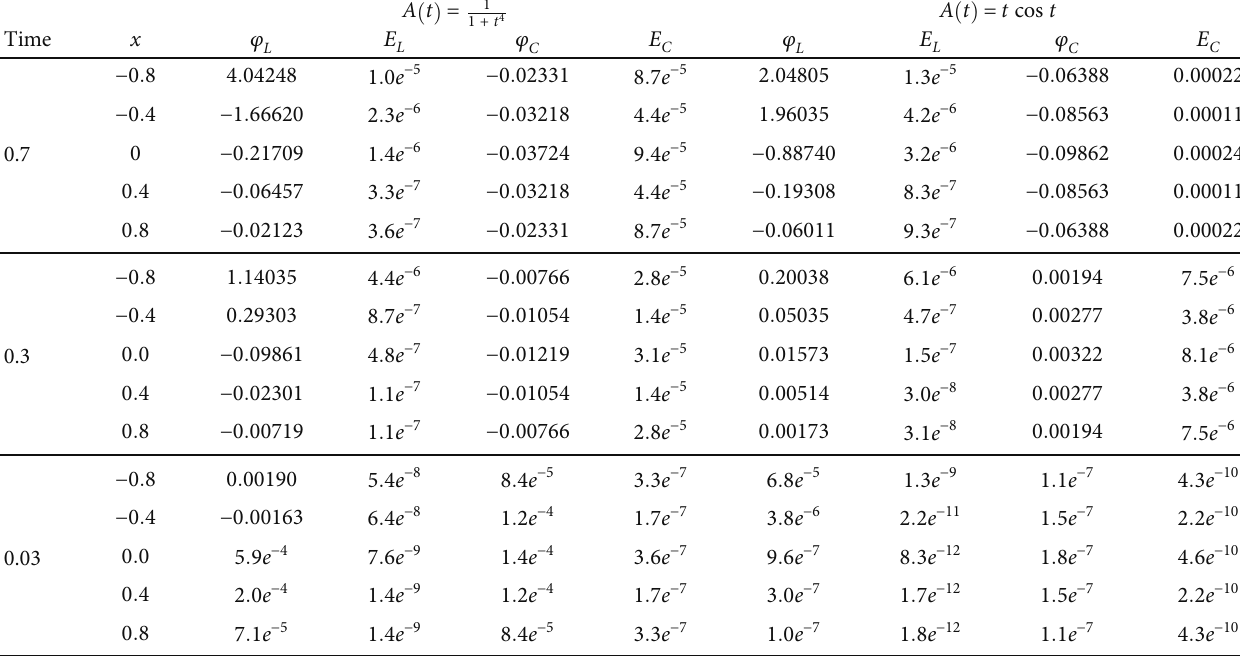
Table 2: N = 17, L ð x Þ = ð 1 + x Þ 3